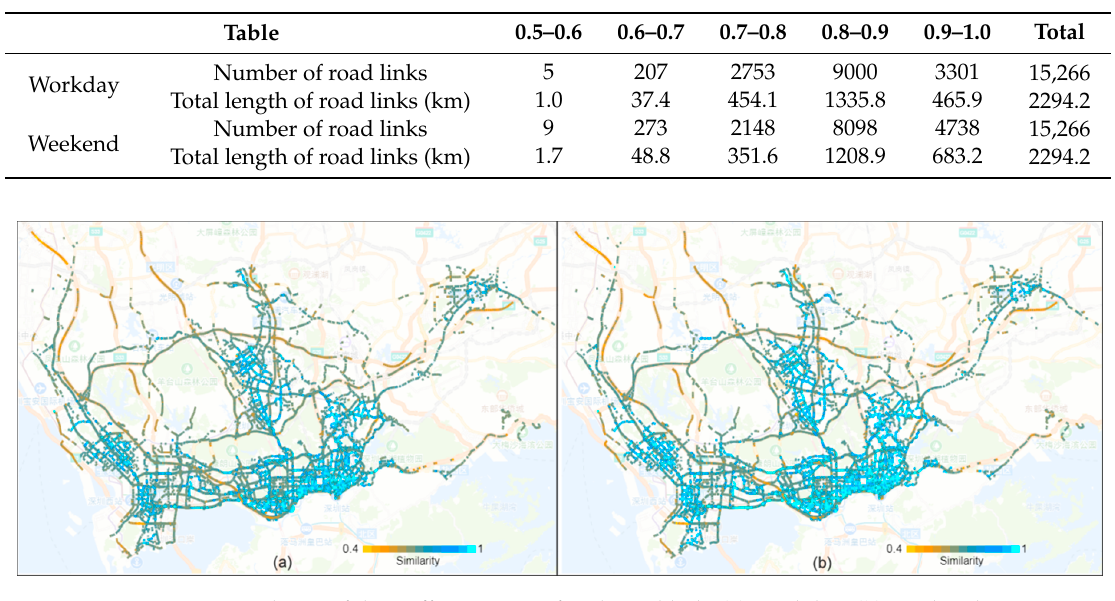
Table 2. Descriptive statistics of road segments with repeated tra ffi c states.